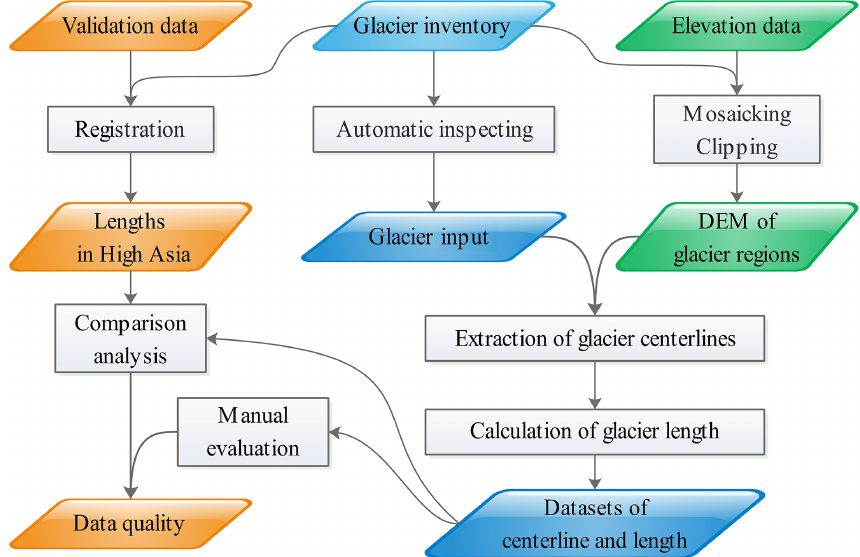
Figure 2. Workflow of the centerline and length of the dataset